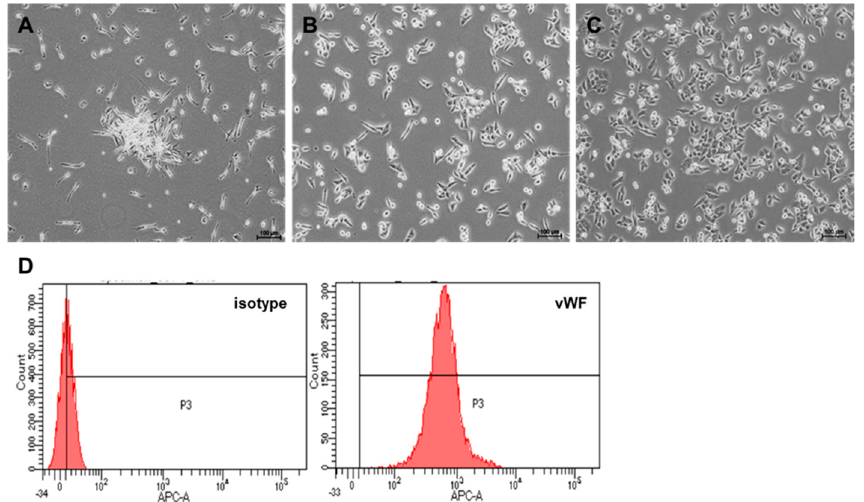
Figure 1. In vitro culture and differentiation of EPCs from PBMNCs. Representative photomicro- graphs of a cell cluster on day 3 ( A ), early EPCs on day 7 ( B ), and late EPCs developed on day 14 ( C ) from healthy volunteers. Expression of the endothelial marker vWF from late EPCs ( D ). The corresponding negative isotype control is shown on the left (isotype) ( D ).